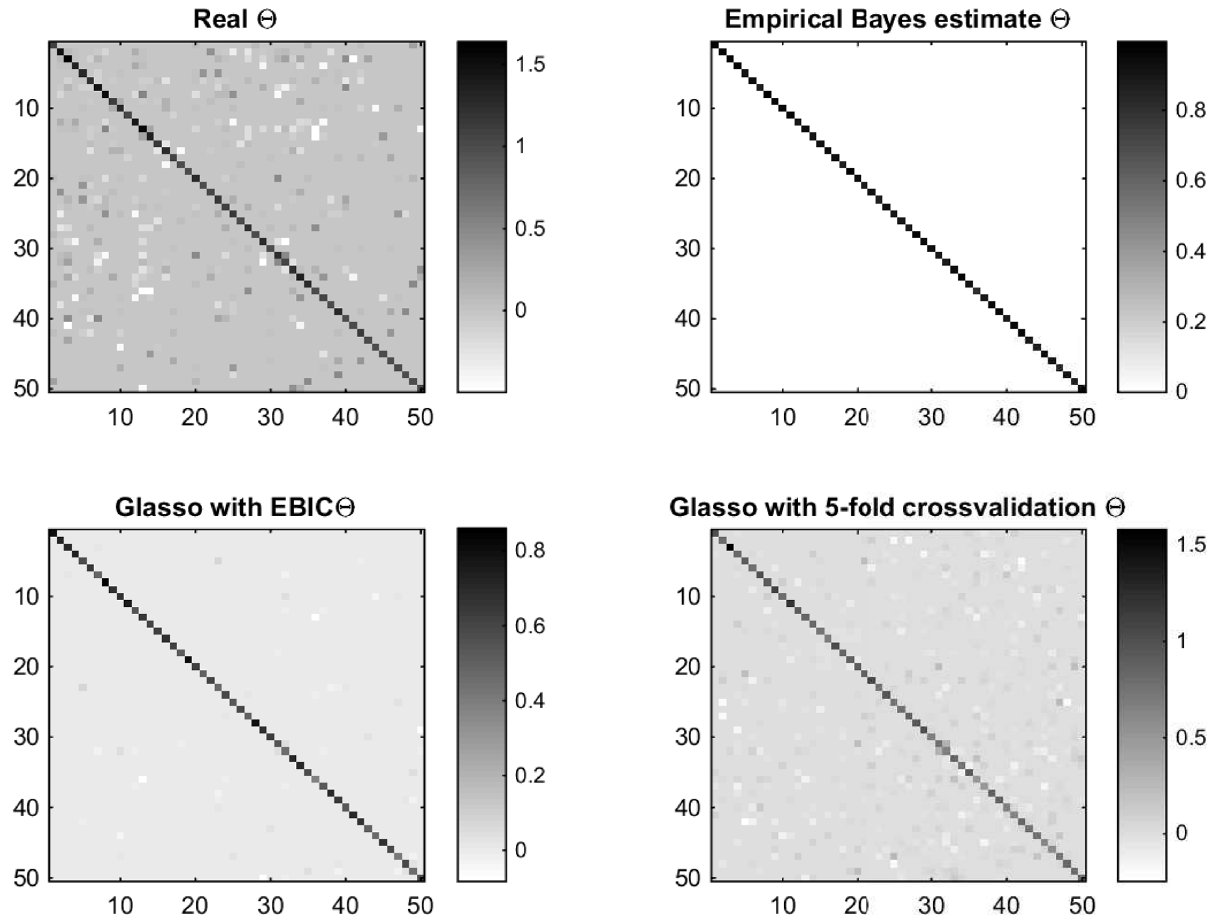
Fig 7. Image plots of the precision matrices. From left to right at the first row: The image plot of the real Θ and empirical Bayes estimate. On the second row: Graphical lasso with the penalization parameter ρ chosen with EBIC and graphical lasso with ρ chosen with 5-fold cross-validation when p = 50 and n =